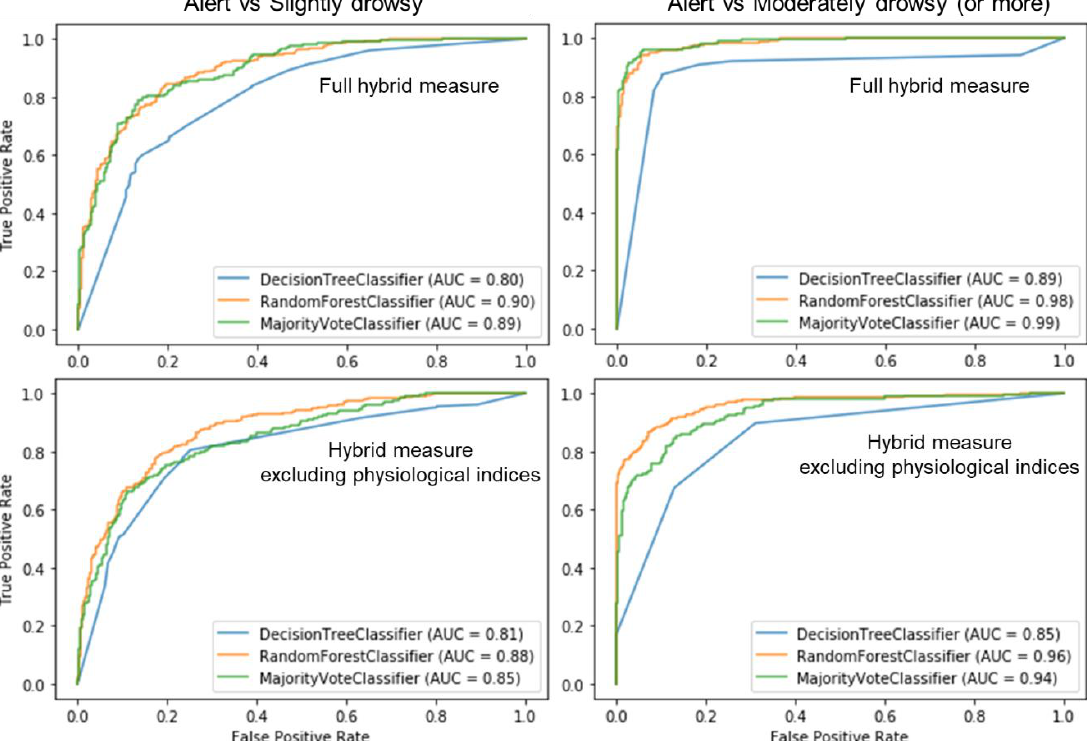
Table 4. Classification results in the case of excluding physiological indices.